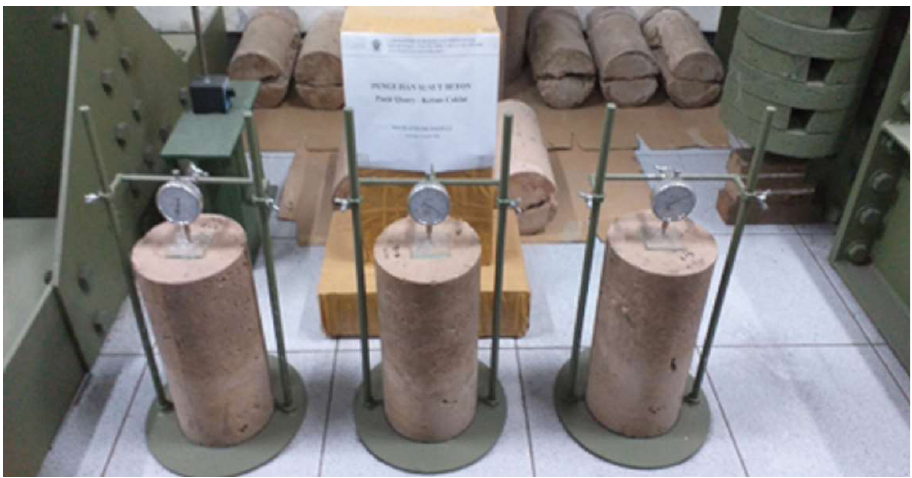
Figure 2. The measurement of shrinkage deformation.